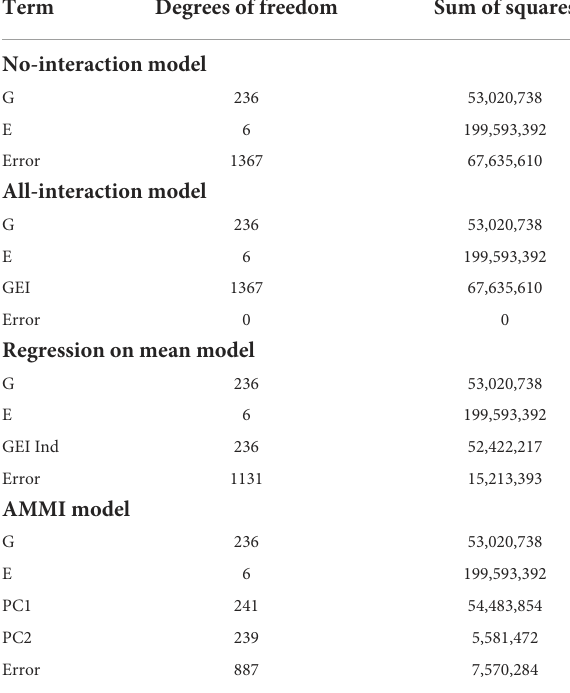
TABLE 3 Summary of degrees of freedom and sum of squares for the sorghum